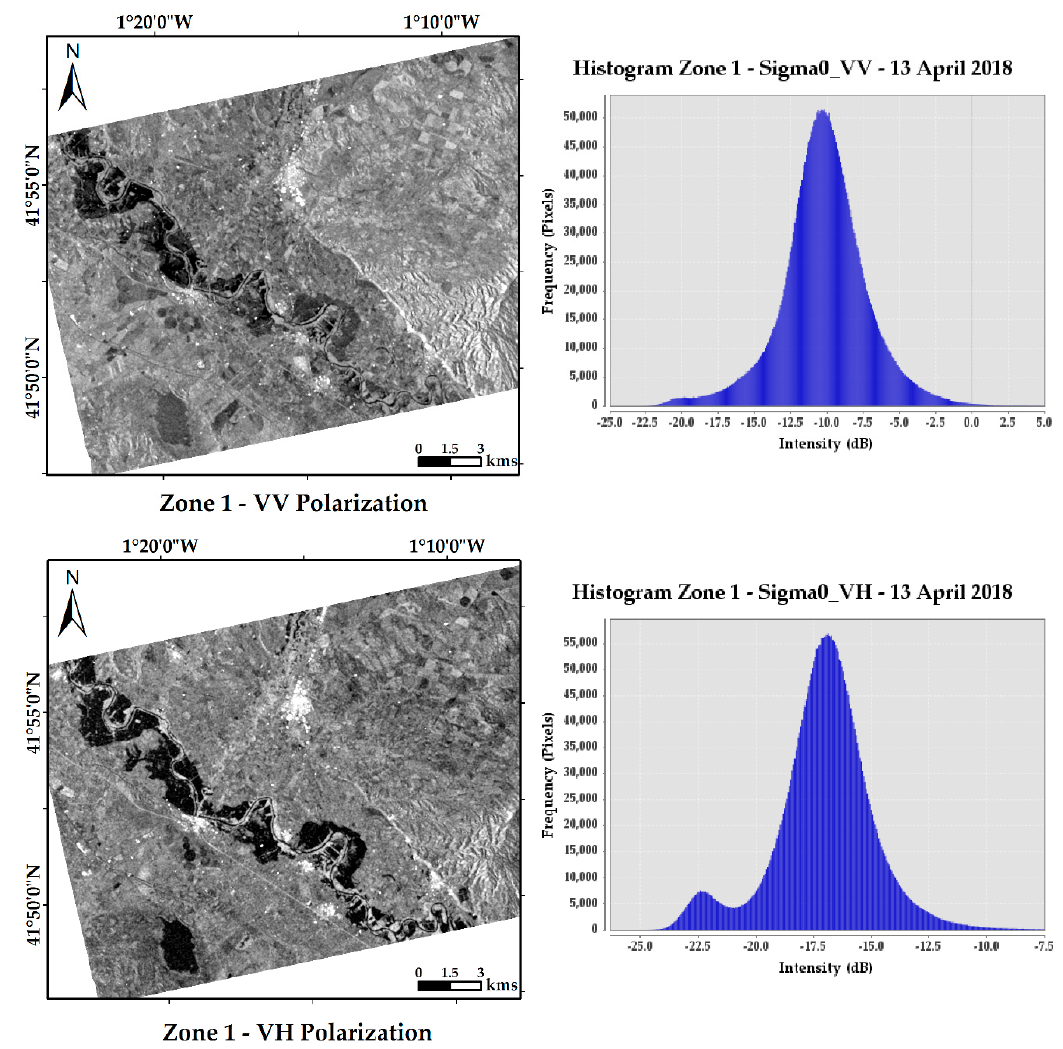
Figure 10. Representation of the characteristic histograms of zone 1: Novillas–Pradilla de Ebro for VV polarization (up) and for the VH (down) in the radar image of 13 April 2018 filtered with the Lee 7 × 7 window size filter.